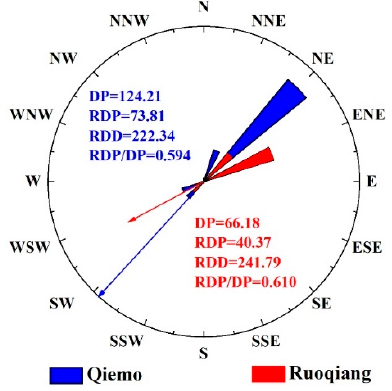
Figure 7. Characteristics of annual DP.